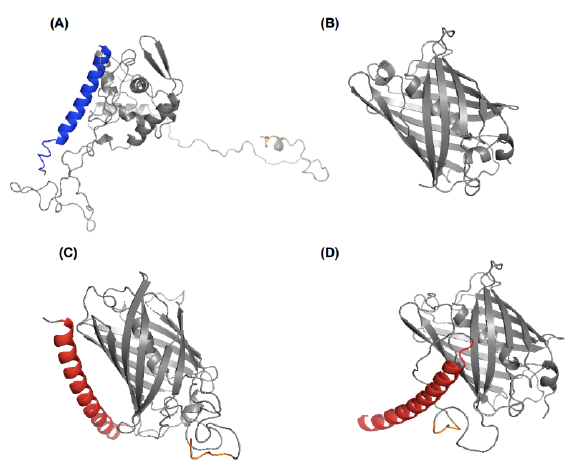
Figure 2. Protein structure prediction of viral coat protein and antigens. ( A ) TEVK protein with K-coil highlighted in blue. ( B ) Native GFP protein. ( C ) GFPE-N and ( D ) GFPE-C proteins with E-coil highlighted in red. His-tag is highlighted in